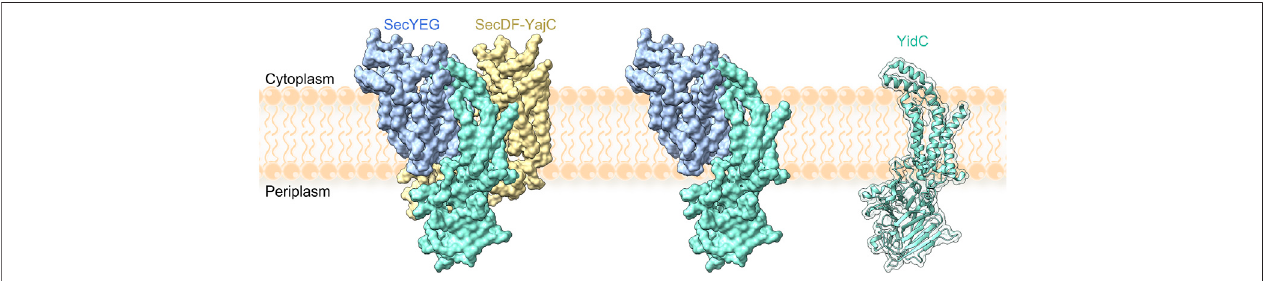
FIGURE4| YidCincomplexwiththeholotransloconSecYEG – SecDF – YajC(left),withSecYEG(middle)andalone(right).Modelswereconstructedbyalignmentof the holotranslocon (PDB: 5MG3 (Botte et al., 2016)) with a recent structure of YidC (PDB: 6AL2 (Tanaka et al., 2018)). TM1 of YidC is missing from all structures.